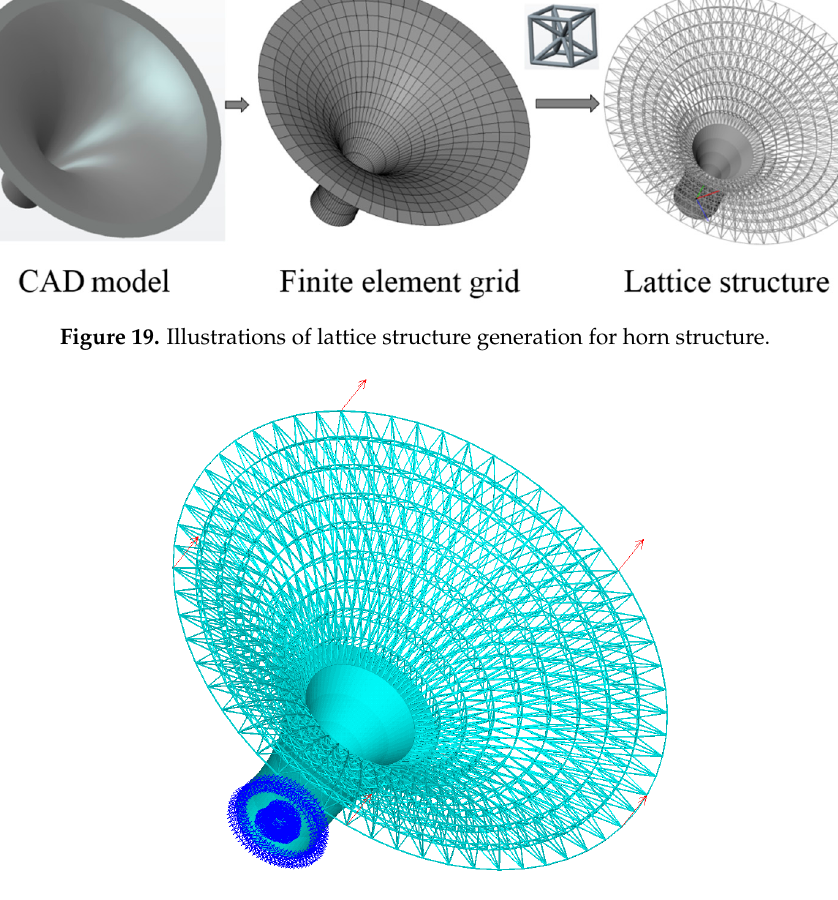
Figure 20. Boundary conditions and loading for horn structure.